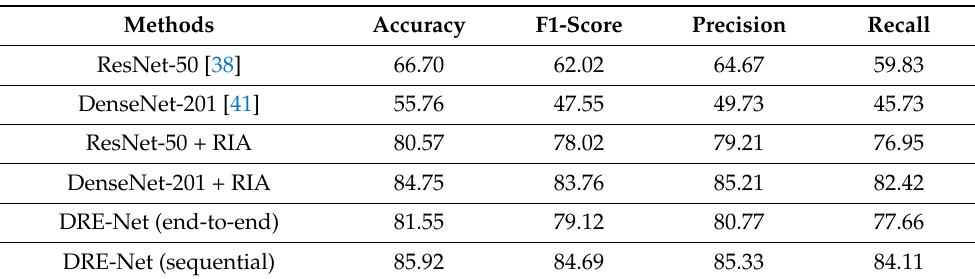
Table 8. Performance comparisons of each sub-network and proposed DRE-Net by end-to-end or sequential training (unit: